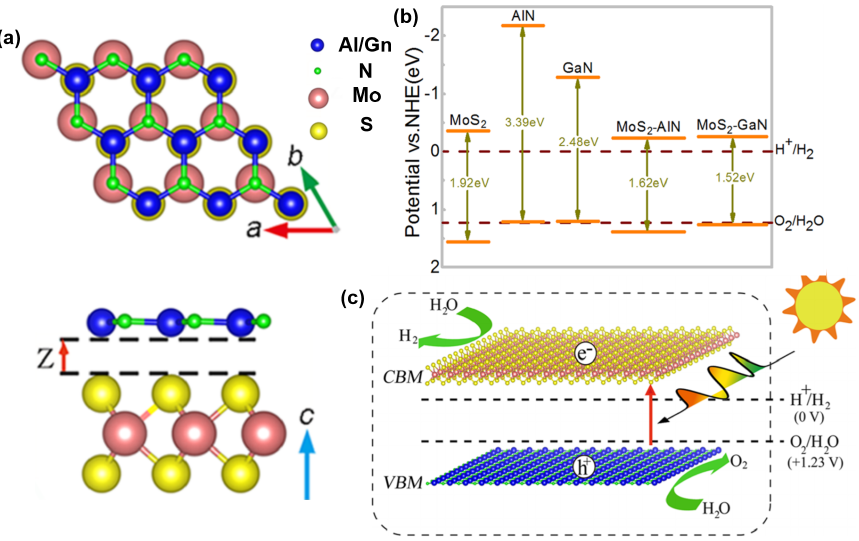
Figure 10. ( a ) Structure illustration of MoS 2 /AlN(GaN) heterostructure. ( b ) Band alignment of MoS 2 hybrid hybridization materials. ( c ) Schematic drawing of photocatalytic water splitting for MoS 2 /AlN(GaN) heterostructures, where VBM refers to valence band maximum and CBM refers to conduction band minimum. Reproduced with permission from reference [166]. Copyright